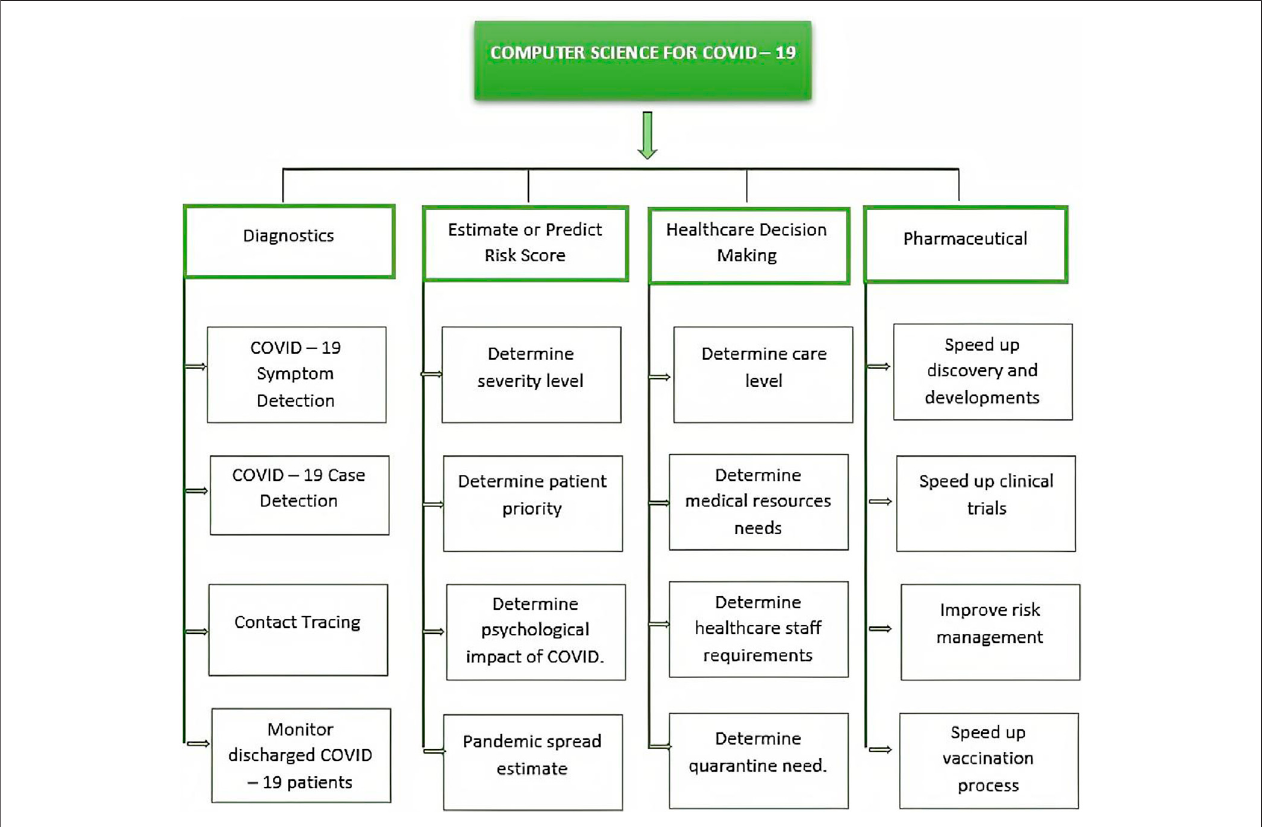
FIGURE 1 | Applications of computer science in